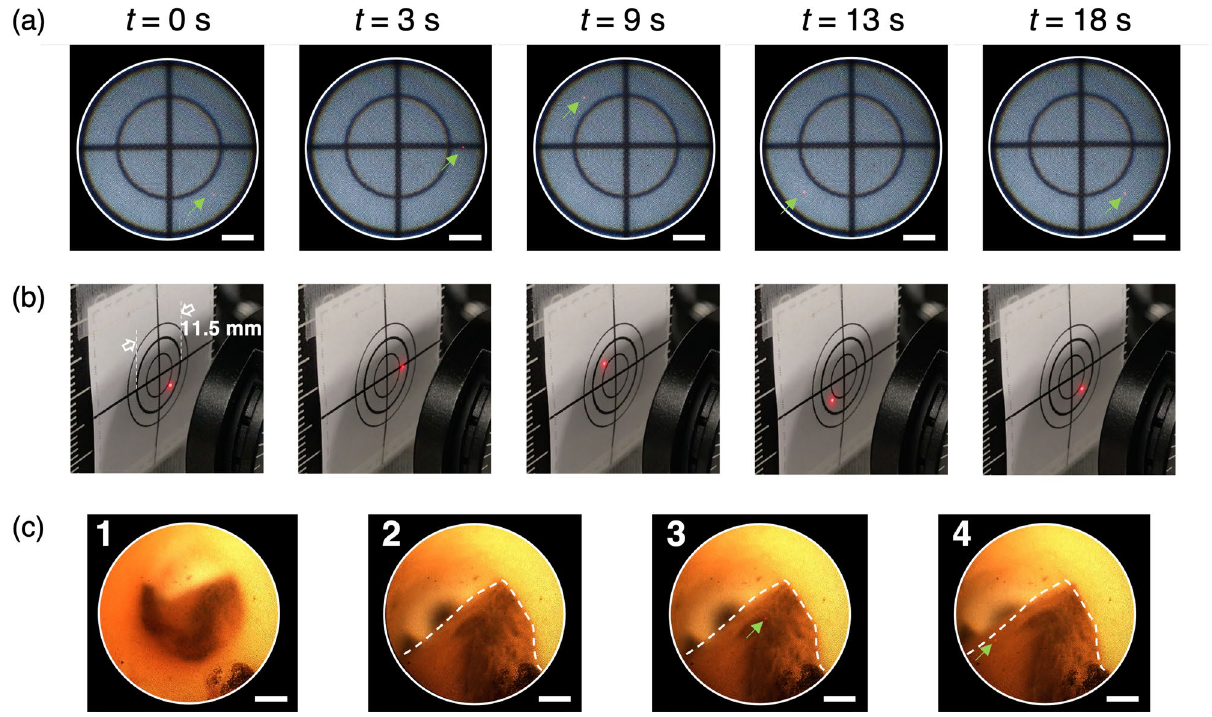
Figure 3. ( a ) Snapshot of the endoscopic view in the laser steering demonstration (Supplementary Movie S1). The green arrows indicate the laser input position on the proximal end. Scale bar: 100 µ m. ( b ) Snapshot of the external view of the distal end. ( c ) Laser steering demonstration using a vascular model with black-colored plaque (Supplementary Movie S2). The white dotted line indicates the plaque. The green arrows indicate the laser input position on the proximal end. Scale bar: 100 µ